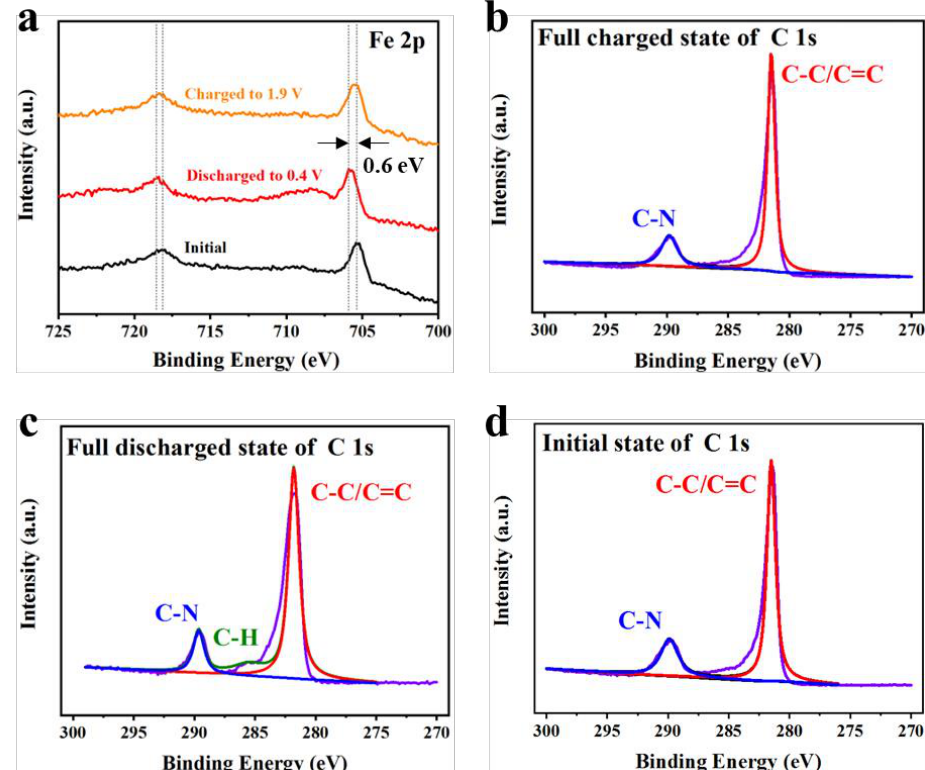
Figure 6. XPS spectra of NMHFC@PPy in different states; ( a ) Fe 2p and ( b – d ) C 1s.